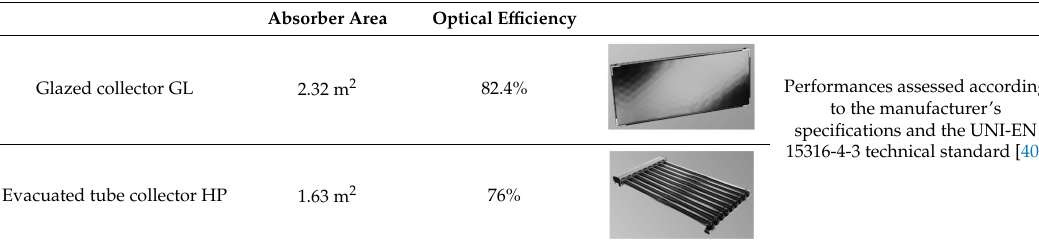
Table 1. Solar collectors’ models used in the